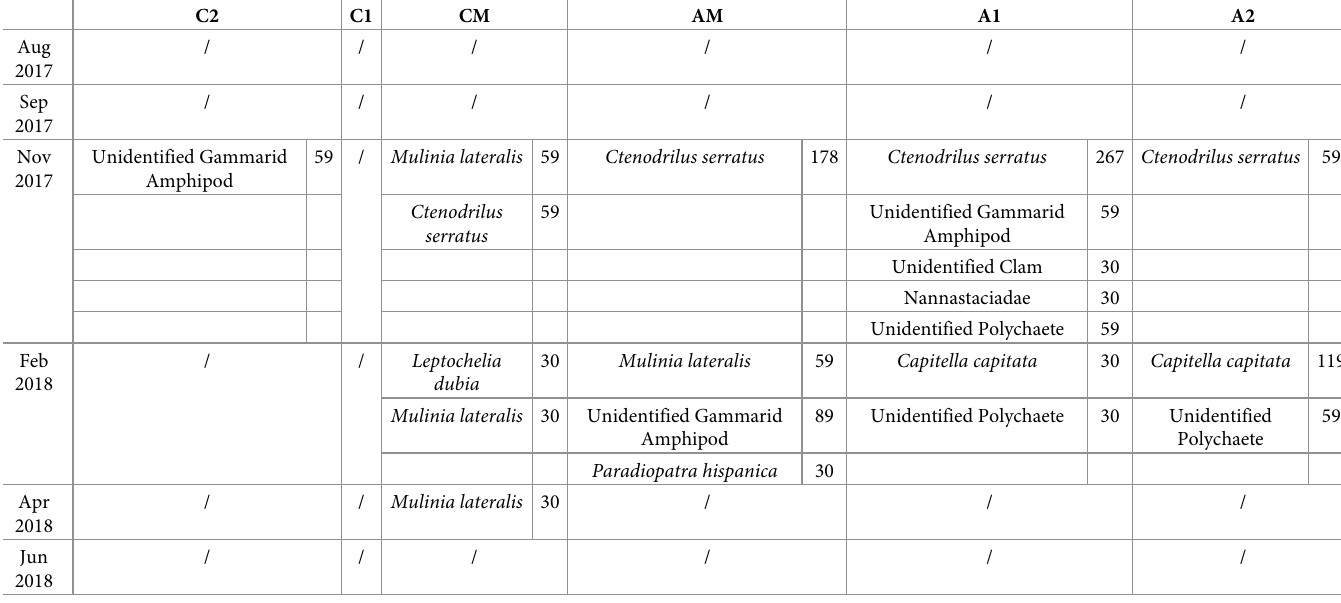
Slash (/) indicates that there was no organism found in that month at that